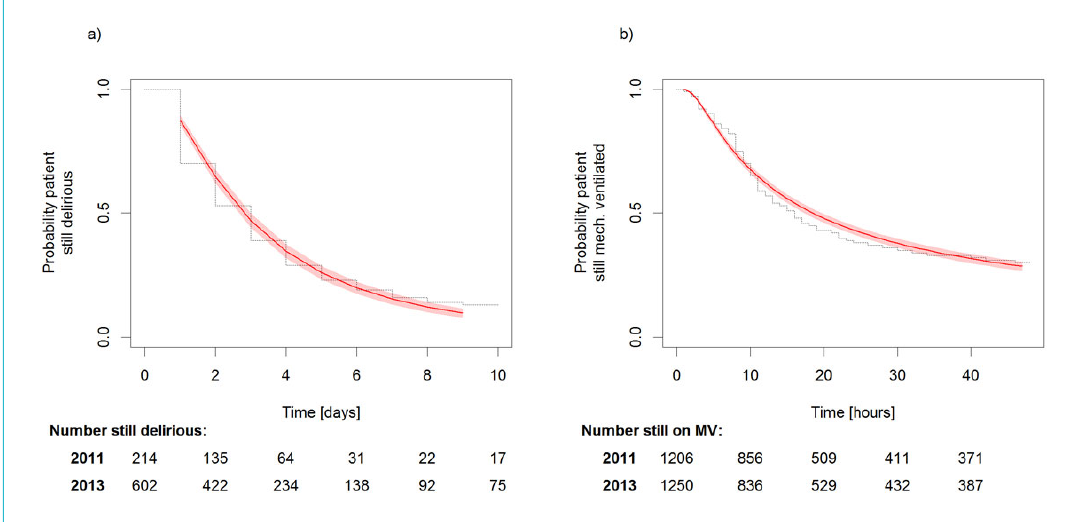
Figure 1: ( a) intensive care unit (ICU) and (b) hospital length of stay modelled parametrically with a gamma and a log-logistic distribution, re- spectively. The non-parametric Kaplan-Meier (KM) curves show the cumulative proportions of patients still in the ICU on day 7 and /or in hos- pital on day 60. Because survival curves from 2011 and 2013 are very similar, we show only the overall KM curve (black line) and parametric fit (red line).